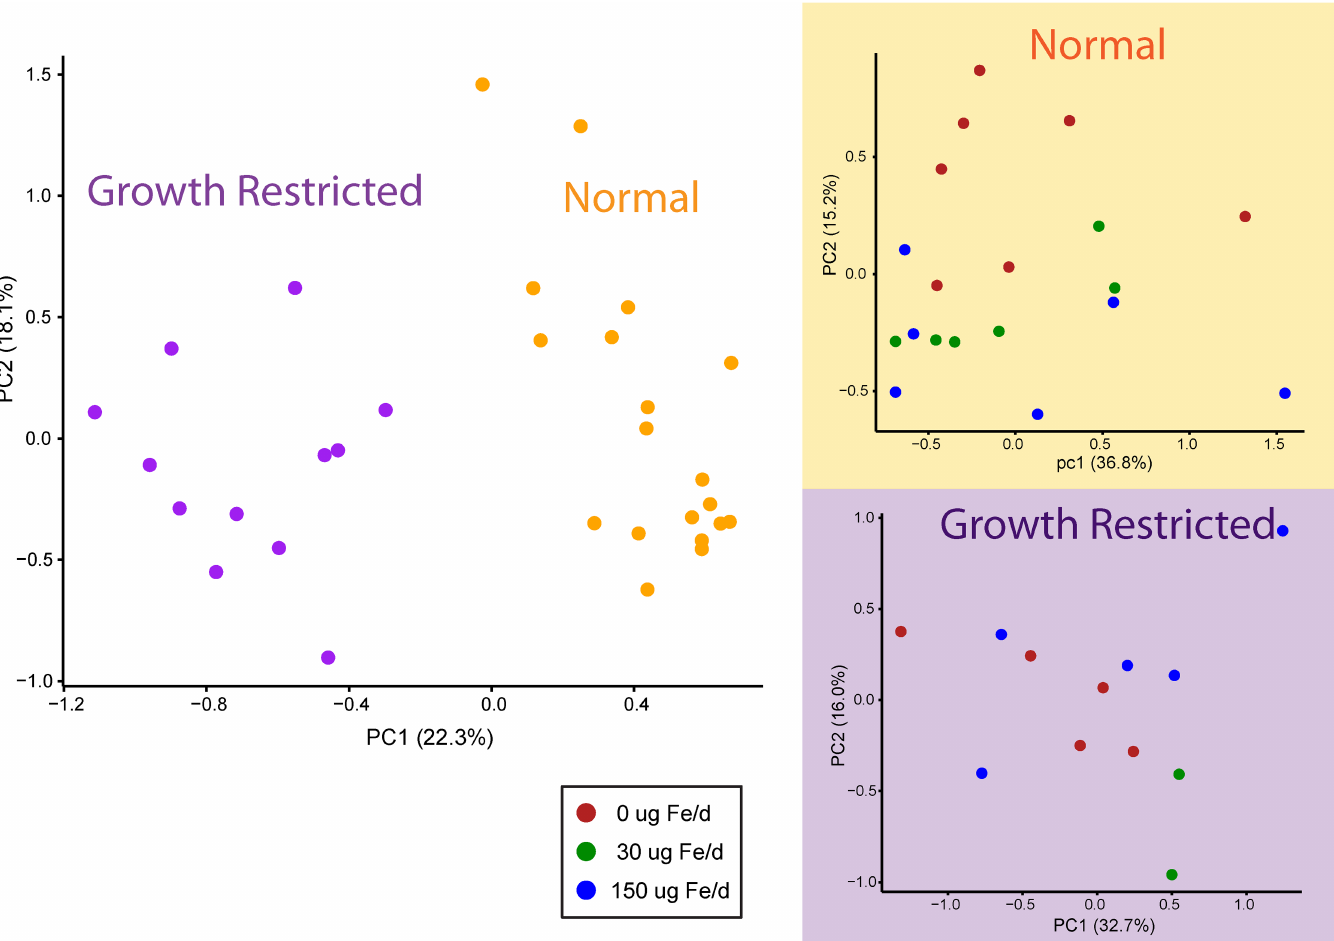
Fig 3. Principal component analysis of plasma metabolites at PD20. Principalcomponentanalysisof plasma metabolitevariablesfrom rat pups at PD20 from either a normal (orange)or growth restricted (purple)group. PC1 explains22.3% of the variation, whereasPC2 explains18.1%. Inset shows PCA of individual groups colored by amount of iron supplemented. 0 μ g (red), 30 μ g (green), 150 μ g (blue) iron.